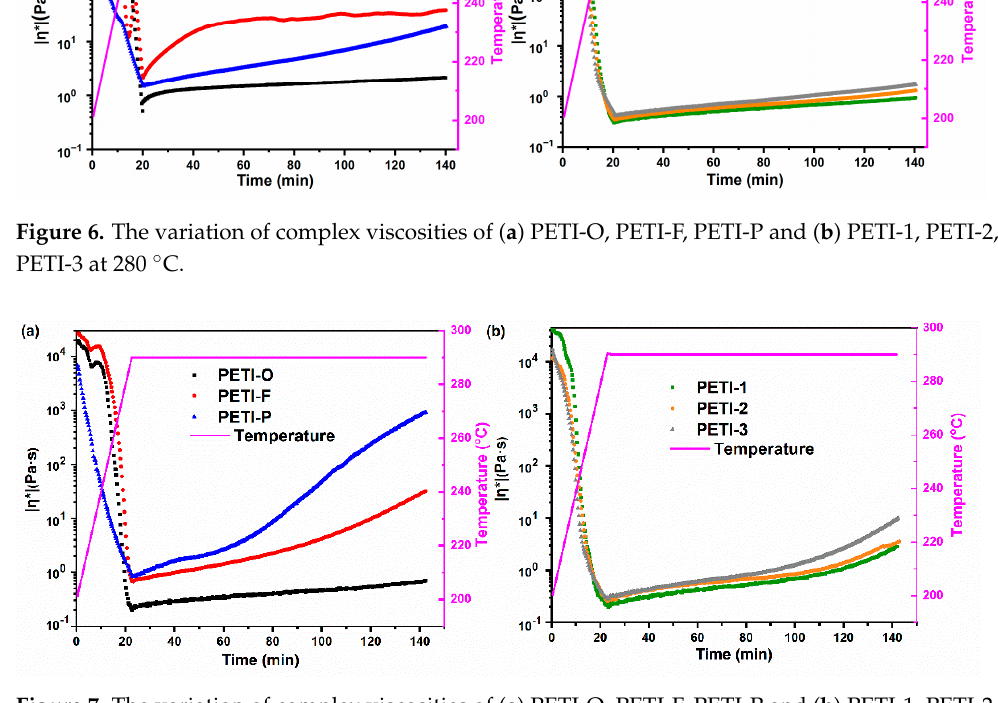
Figure 7. The variation of complex viscosities of ( a ) PETI-O, PETI-F, PETI-P and ( b ) PETI-1, PETI-2, PETI-3 at 290 °C.